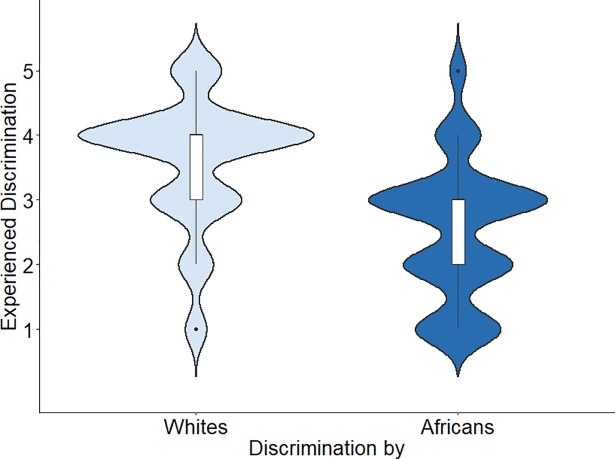
Discrimination experiences.Individuals experienced more skin-tone discrimination by Whites than by Africans. Response distributions and boxplots are displayed. Different colors are used for presentational purposes. The y-axis shows the full range of possible values (1–5).